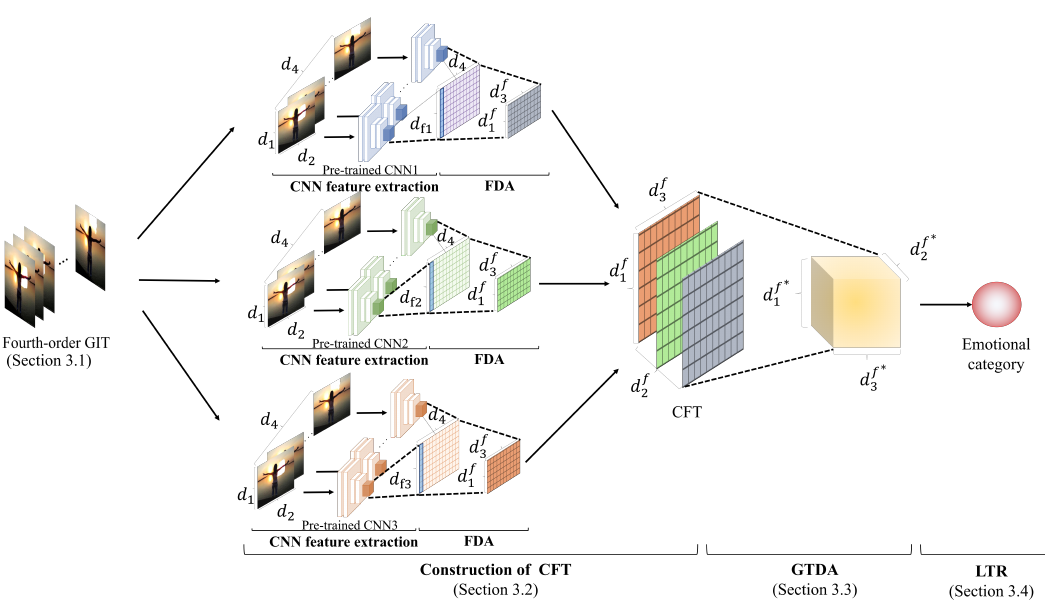
Figure 2. Overview of our method. We construct the new gaze-based image representation and extract multiple convolutional neural network (CNN) features. By aligning these CNN features, we construct a CNN feature-based tensor (CFT) and apply both general tensor discriminant analysis and logistic tensor regression to the CFT. Finally, our method classifies images into emotional categories using outputs of the proposed network. Details of the procedures are shown in Sections